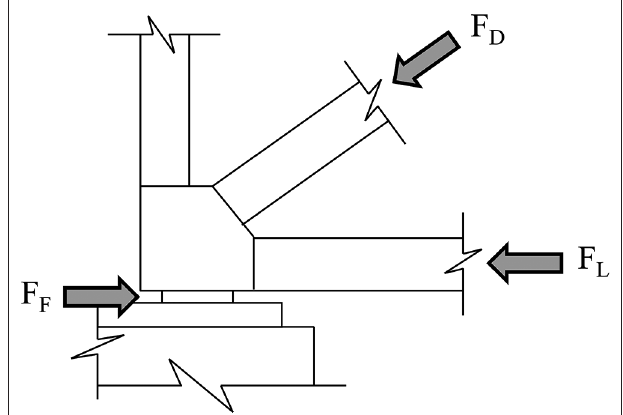
FIGURE 9 | Free-body diagram at the arch bearings.